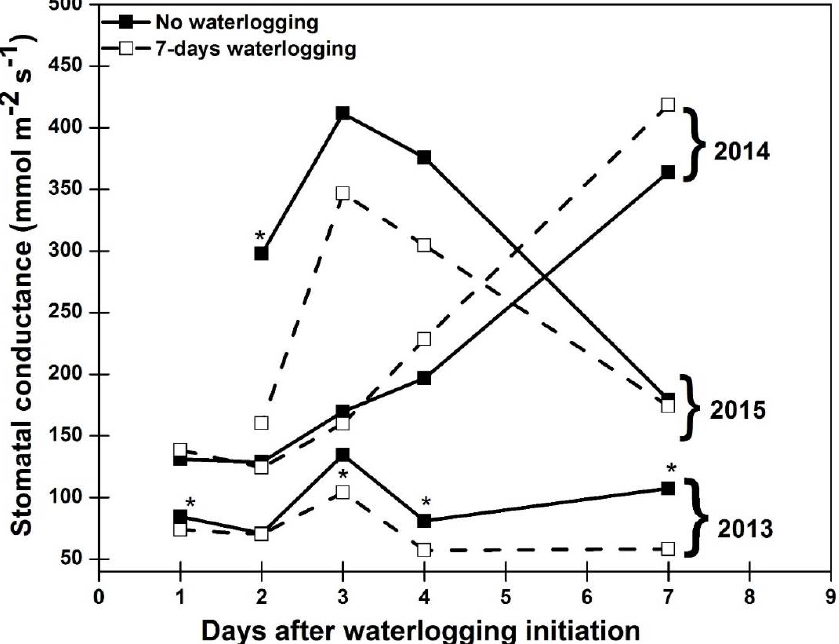
Figure 5. Changes in leaf stomatal conductance in 7-days waterlogged and non-waterlogged treatments in the 2013, 2014 and 2015 growing season. * Indicates significant differences between 7-days waterlogged and non-waterlogged treatments for that particular day at p < 0.1.